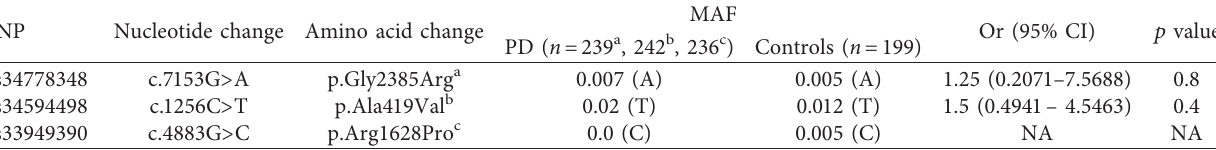
Table 4: The allelic frequency and odds ratios for the positive LRRK2 Asian disease-associated variants. SNP